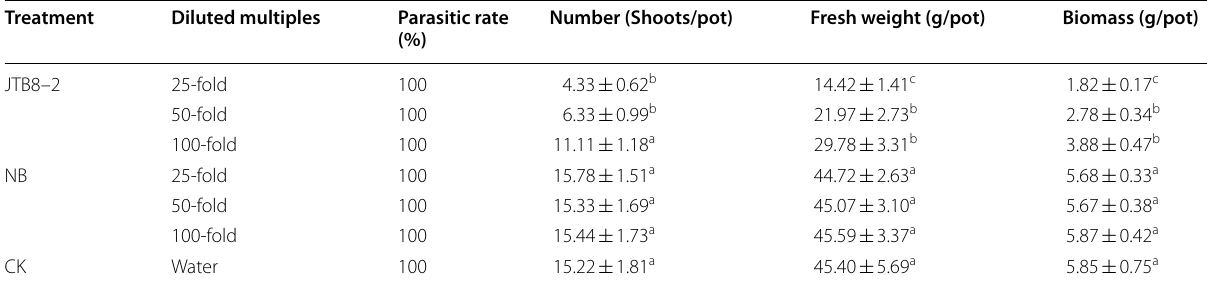
The results of variance analysis showed significant differences between different treatments, the different small letters represent significance at 5% level